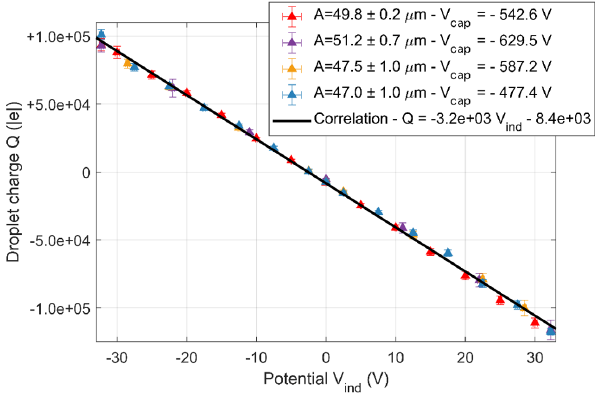
Figure 6. Droplet charge versus electrostatic inductor voltage. The colours identify different tests performed to ensure there is no droplet charge modification over time and manipulations. Error bars represent the standard deviation of the droplet radii evaluated. The parameter V cap is the potential at the capacitor to measure the droplet charge. Note that the radius of the droplet is deduced from the reversed Beard (1976) model and its terminal velocity – with the latter being measured by optical shadowgraphy. See Appendix B for more further